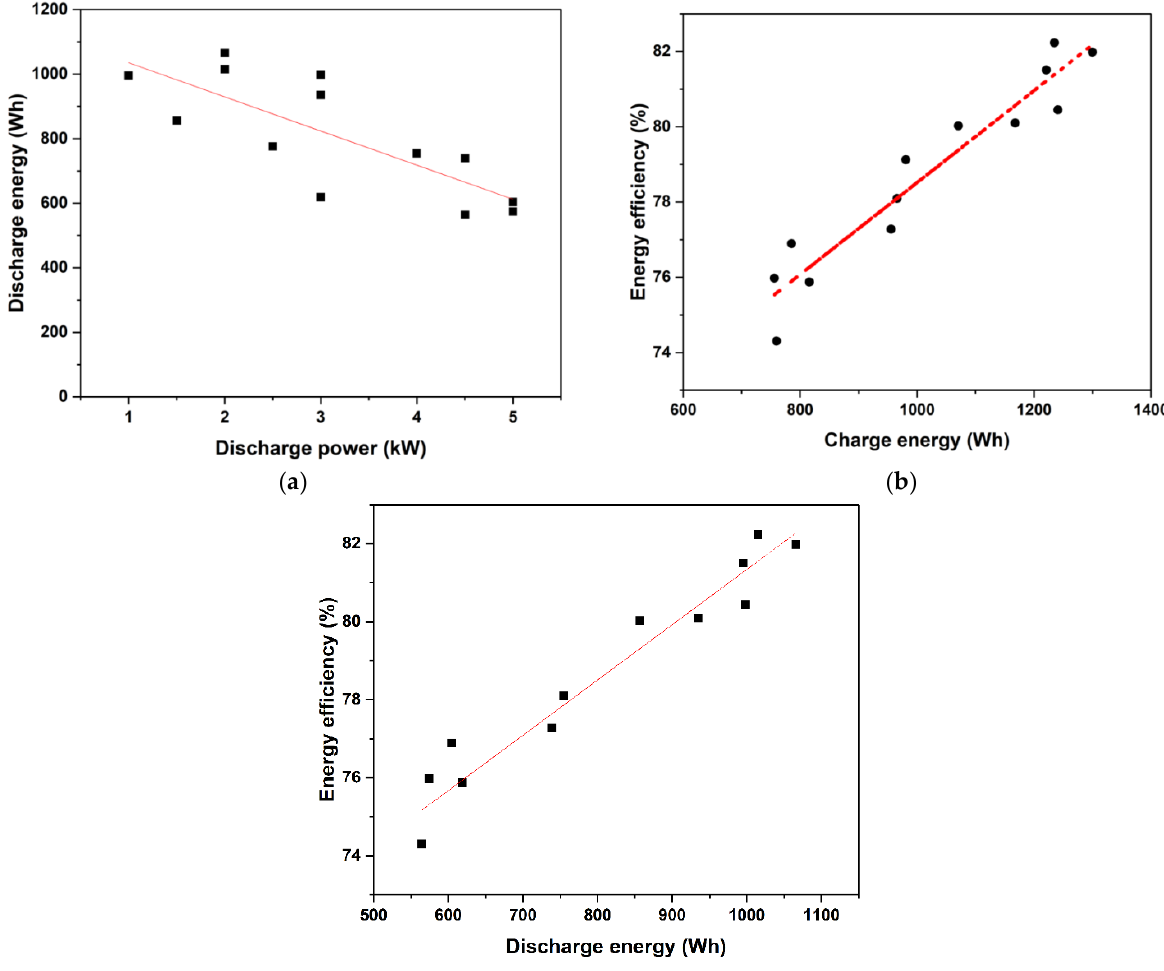
Figure 6. Measured variation of ( a ) discharged energy with discharging power, ( b ) round-trip energy efficiency with charging energy, and ( c ) round-trip energy efficiency with discharging energy for all the power ratios and power levels studied.